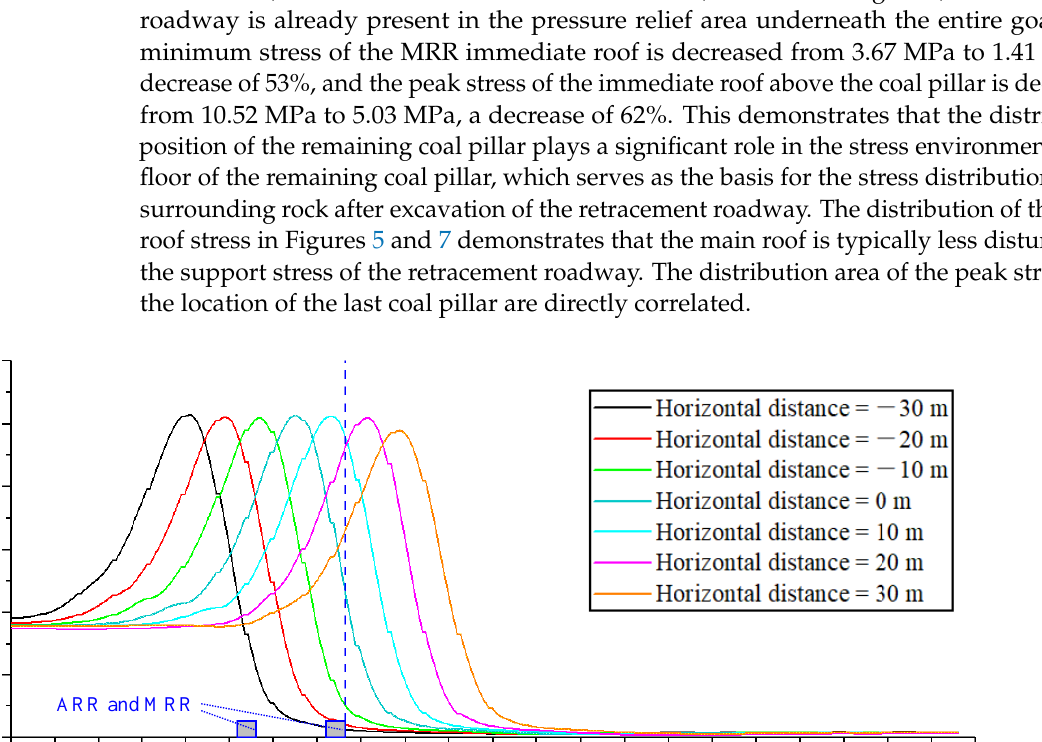
Figure 7. Distribution of main roof stress at different horizontal distances.